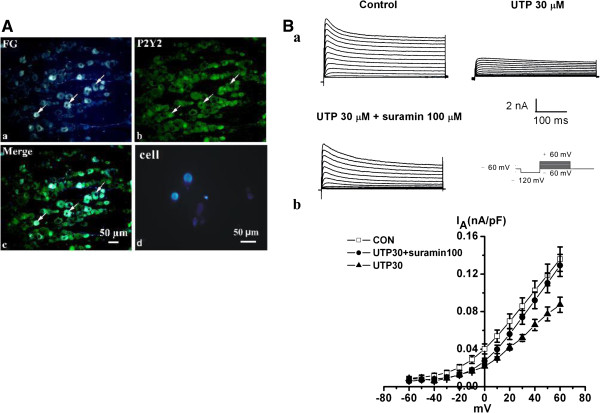
Effect of UTP and suramin on IA of small-diameter and FG-labeled TG neurons, with diameters ranging from 18 to 39 μm in control rats. (A) Fluorescence microscopic view of TG neurons from control rats. (a) Retrograde labeling of TG neurons (blue) innervating whisker pad skin. (b) P2Y2 receptor-positive (green) TG neurons were seen in the section of TG. (c) The merged images (purple) of retrograde labeling of TG neurons and P2Y2 receptor-positive TG neurons from the same section, indicating co-localization. (d) Retrograde labeling of TG neurons (blue) innervating whisker pad skin in cultured TG neurons. (B) Electrophysiology recording for small-diameter and FG-labeled TG neurons in control rats. (a) Representative traces showing that the application of 30 μM UTP reduced IA. Suppression of the mean peak amplitudes of IA seen after UTP application was antagonized by suramin 100 μM. (b) Current–voltage relationship for the effects of UTP and suramin on IA. Each value represents the mean ± SEM (con: 0.14 ± 0.01 nA, n = 9; UTP: 0.09 ± 0.01 nA, n = 20, p < 0.05 vs control; suramin: 0.13 ± 0.01 nA, n = 9). IA was initiated via a prepulse (100 ms) of −120 mV and test pulses (400 ms) from −60 to +60 mV in a 10 mV step.